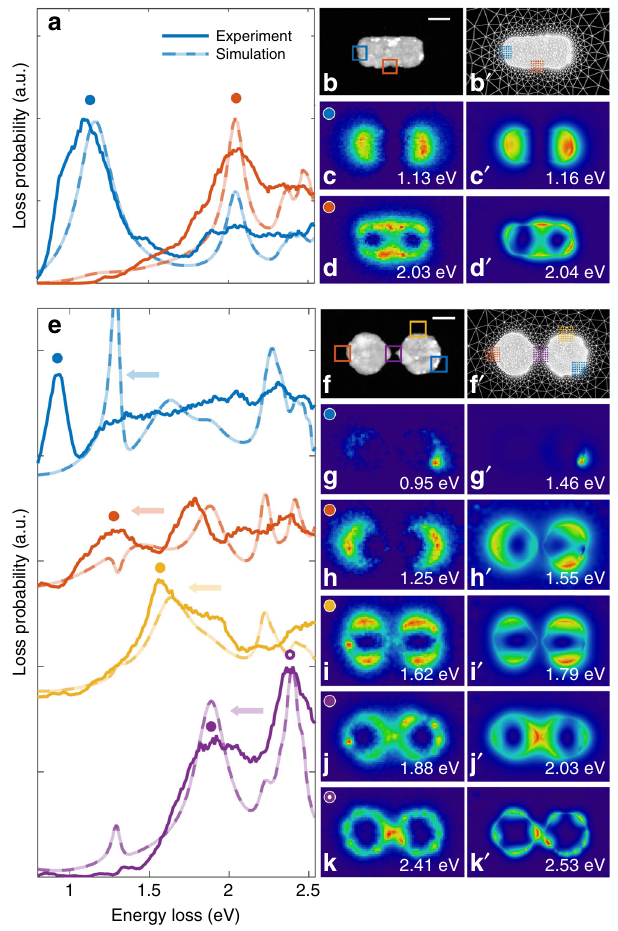
Fig. 2 Selected EELS spectra and maps for nanocuboid and coupled nanodisks. a Measured and simulated EELS spectra for nanocuboid. The red and blue squares in b indicate the regions over which spectra are averaged. c and d EELS maps of the dipolar and quadrupolar modes at the resonance energies indicated by symbols in a . b ʹ – d ʹ Same as b – d , but for simulation results. e – k ʹ Report results for the coupled nanodisks. Simulated spectra in e are shifted by 0.2 eV to lower energies (see arrow ) to achieve better agreement for the modes at higher loss energies. The scale bar is 100